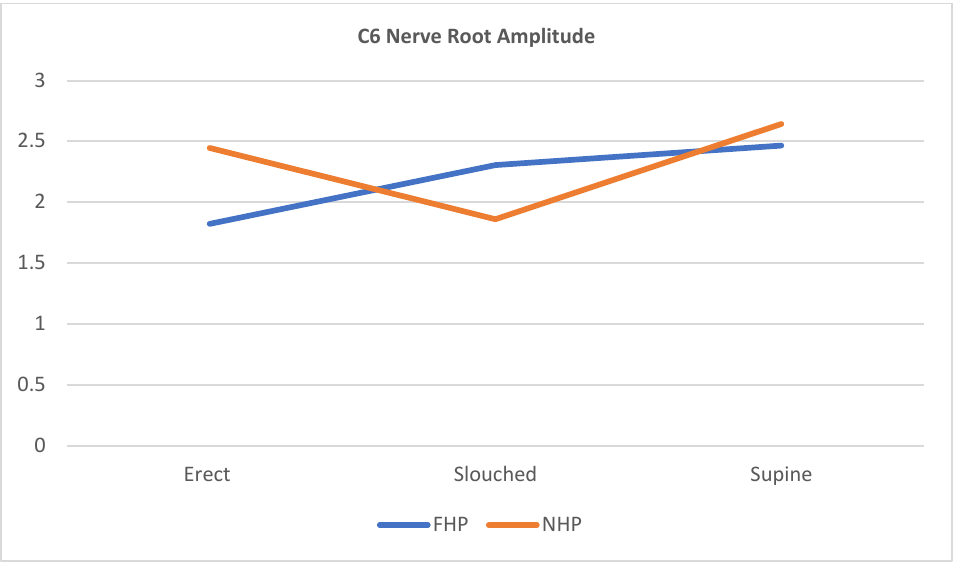
Figure 7. Scatterplot line of cervical nerve C6 amplitude relationship with the different sitting positions for participants with forward head posture (FHP) and normal head posture (NHP). The graph highlights that the FHP group has shown an increased amplitude during slouched sitting compared to erect sitting. The supine position shows the highest nerve peak from all three positions.